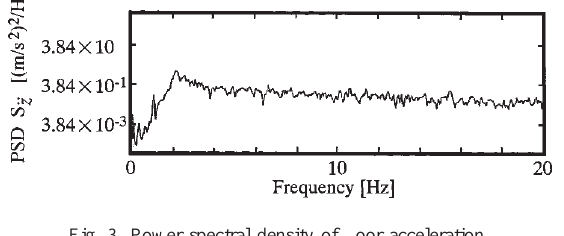
Fig. 3. Power spectral density of floor